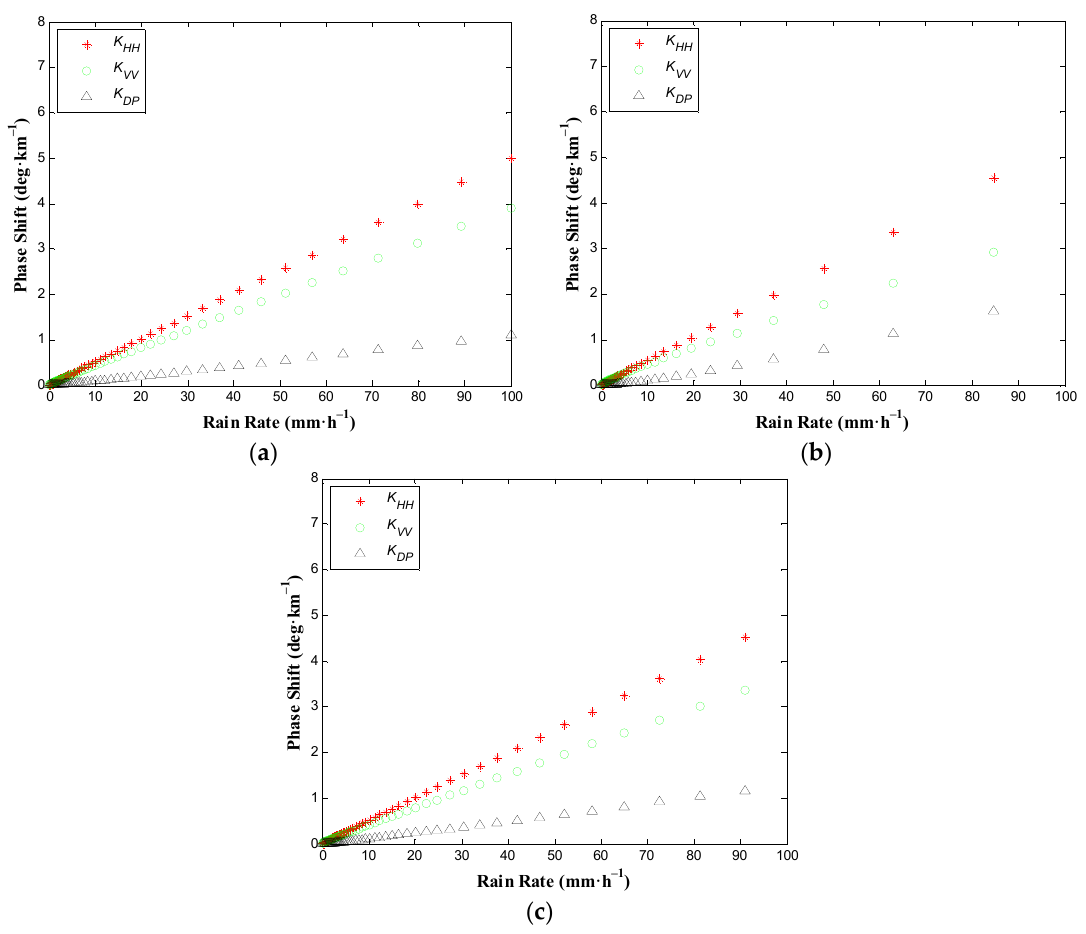
Figure 5. Polarimetric propagation parameters vs. rain rate under three different rain types at the L1 (1575.42 MHz) frequency of GPS signals. ( a ) Stratiform rain; ( b ) cumuliform rain; ( c ) mixed clouds rain.